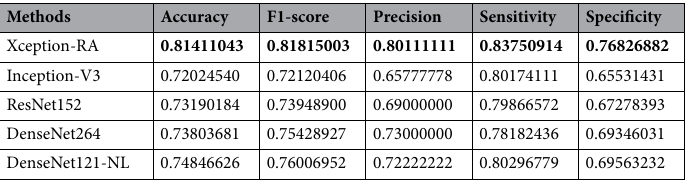
Table 2. Comparison of results for different models. Significant values are in bold.